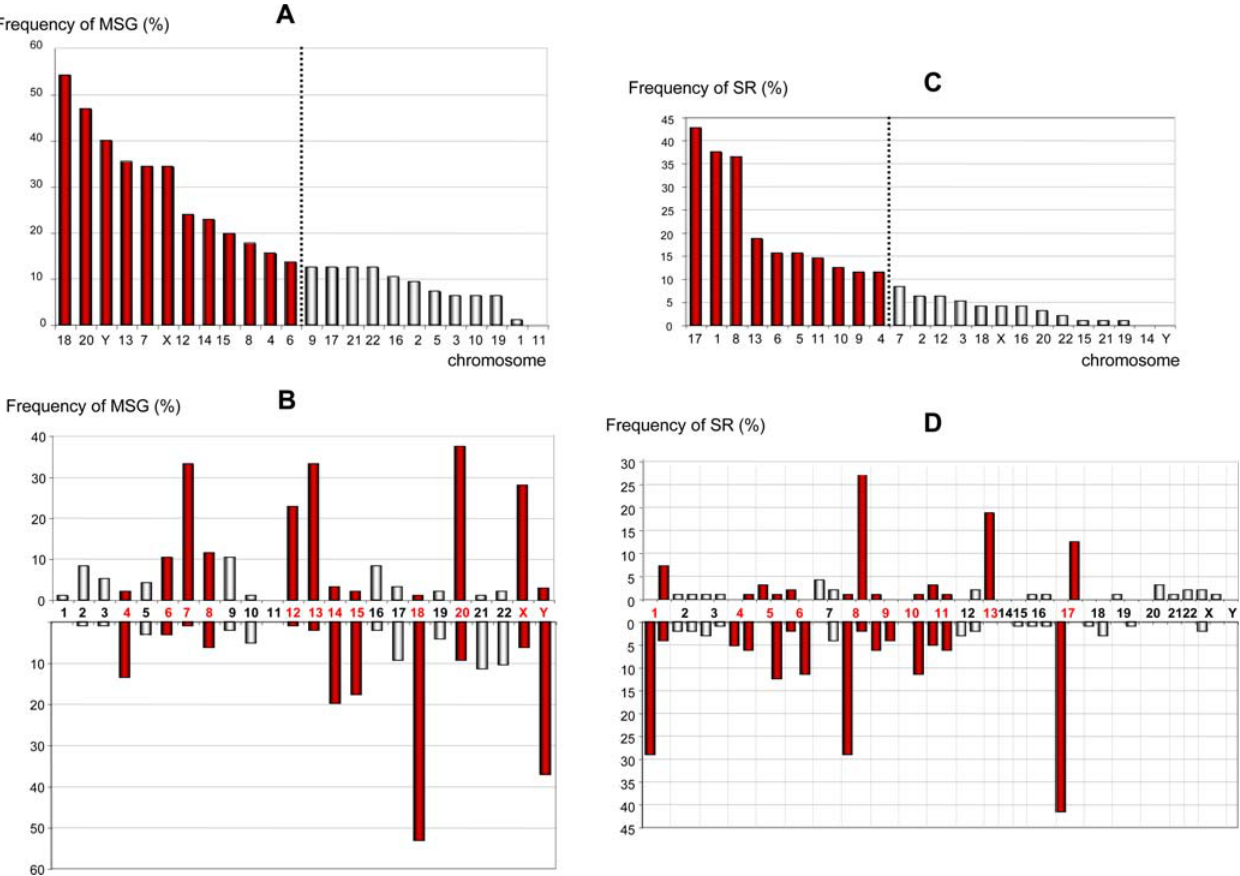
Figure 1. Involvement of chromosomes in missegregations (MSG) and structural rearrangements (SR) in our series of 96 near- diploid colorectal tumors. Frequencies of MSG (A) with their resulting gains and losses (B) and frequencies of SR (C) with their resulting gains and losses (D) are represented. The dotted line represents the cut-off value indicated by the likelihood statistical modeling that discriminates chromosomes that are likely to be selected for during tumor progression (red) from those constituting the background of chromosomal instability (grey). In B and D, each bar represents the percentage of loss (lower) or gain (upper) of a chromosome (B) or chromosome arm (D, p arm first, then q arm for non-acrocentric